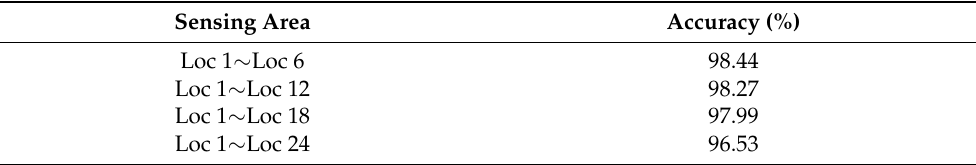
Table 3. The AP-DCN recognition accuracy of different sensing